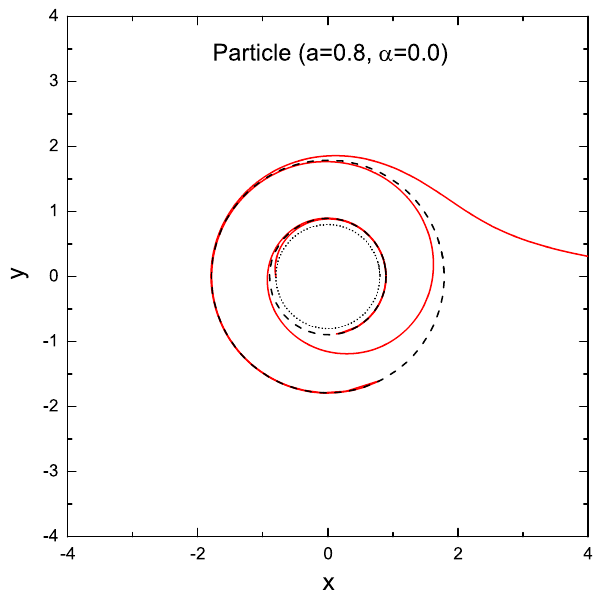
Fig. 5 The trajectory of a test particle of the Kerr black hole with a = 0 . 8. The trajectory of a test particle is plotted by the solid line , two horizons are illustrated by the dashed circles and the ring singularity is shown by a short dot circle